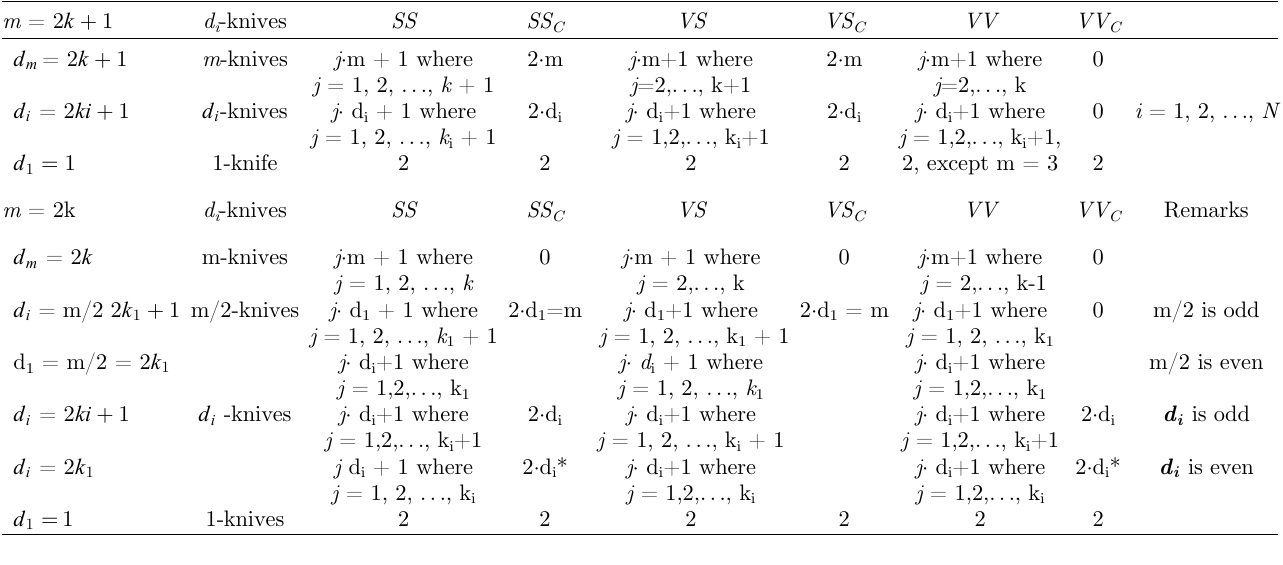
bodies with d i -knives for odd and even m. m